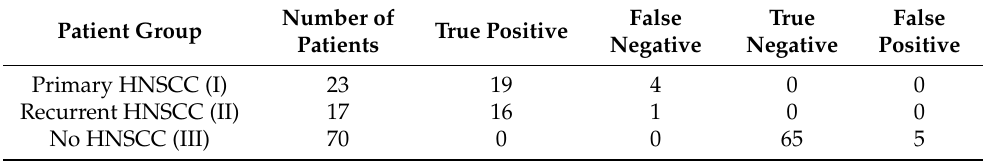
Table 3. Distribution of diagnostic findings (as compared to pathology) by